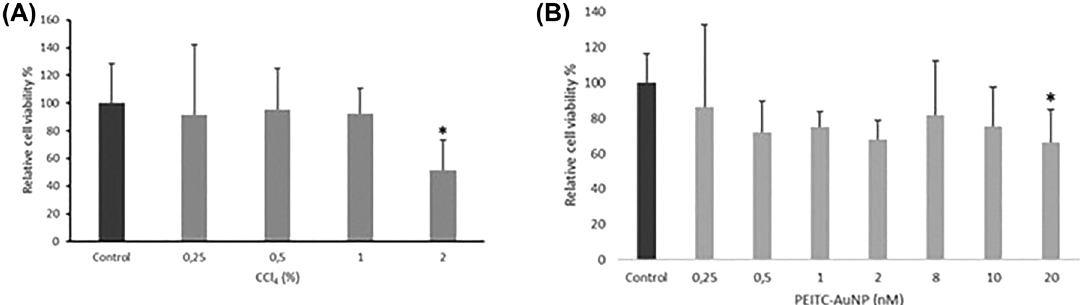
Figure 1: Cytotoxic activities of CCl 4 (A), and PEITC-AuNP administration on HepG2 cells (B). * p<0.05 vs. control.